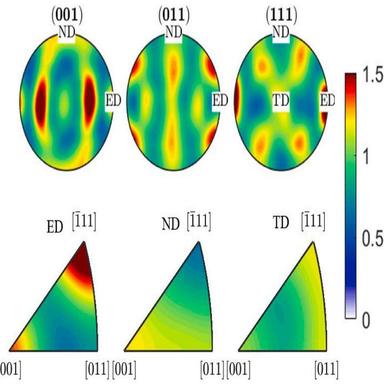
Pole figure and inverse pole figures of the AA7075-O extruded tube.